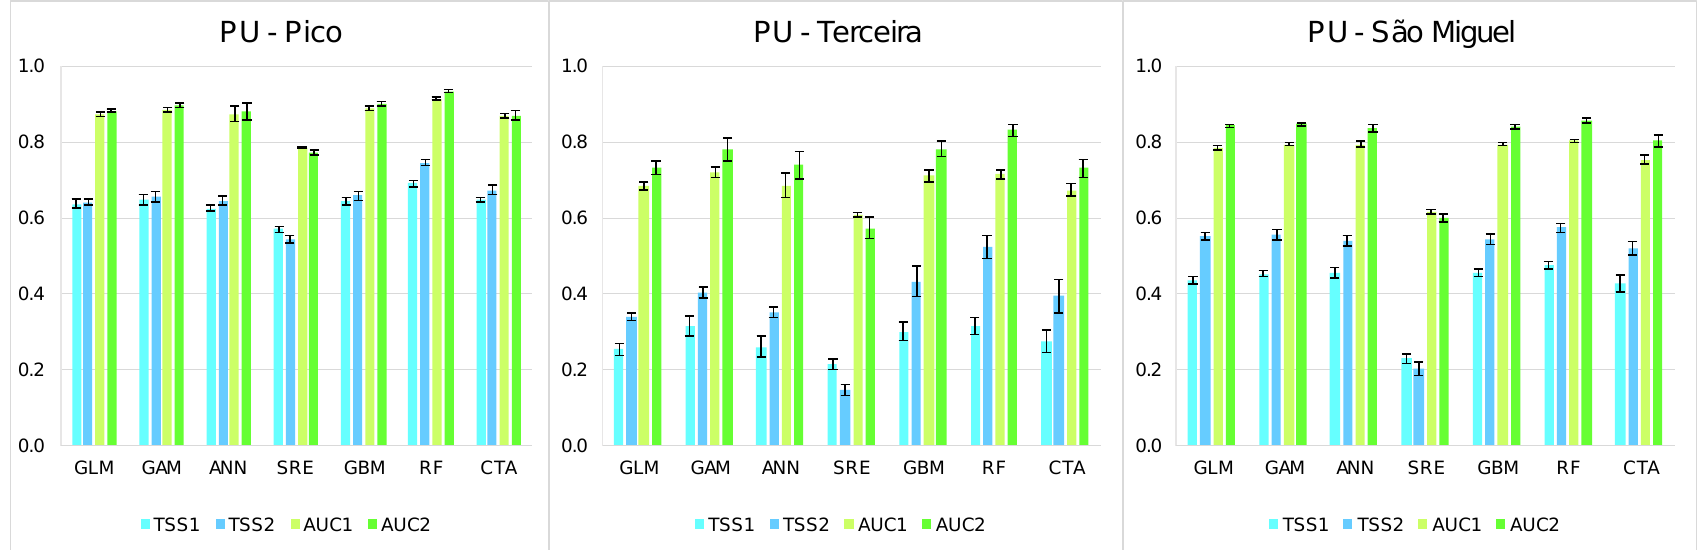
Figure 4. Evaluation of P. undulatum (three distinct islands) distribution models/algorithms (mean values) by the true skill statistic (TSS) and the receiver operating characteristics curve (AUC), using two different EGV sets: EGV set 1 (climatic variables) and EGV set 2 (climatic and topographic variables). The models/algorithms were: GLM (generalized linear models), GAM (generalized additive models), ANN (artificial neural networks), SRE (surface range envelope), GBM (generalized boosted regression models), RF (random forest), and CTA (classification tree analysis). TSS1: TSS of EGV set 1; TSS2: TSS of EGV set 2; AUC1: AUC of EGV set 1; AUC2: AUC of EGV set 2. Error bars correspond to the standard deviation. For more details, see Supplementary Material Tables S1 – S3.